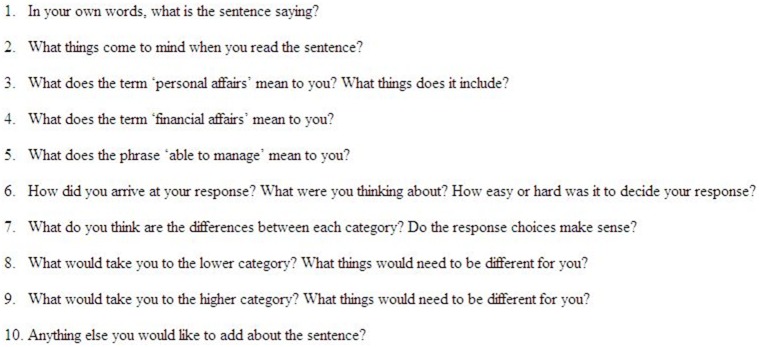
Scripted probes for the cognitive interview.